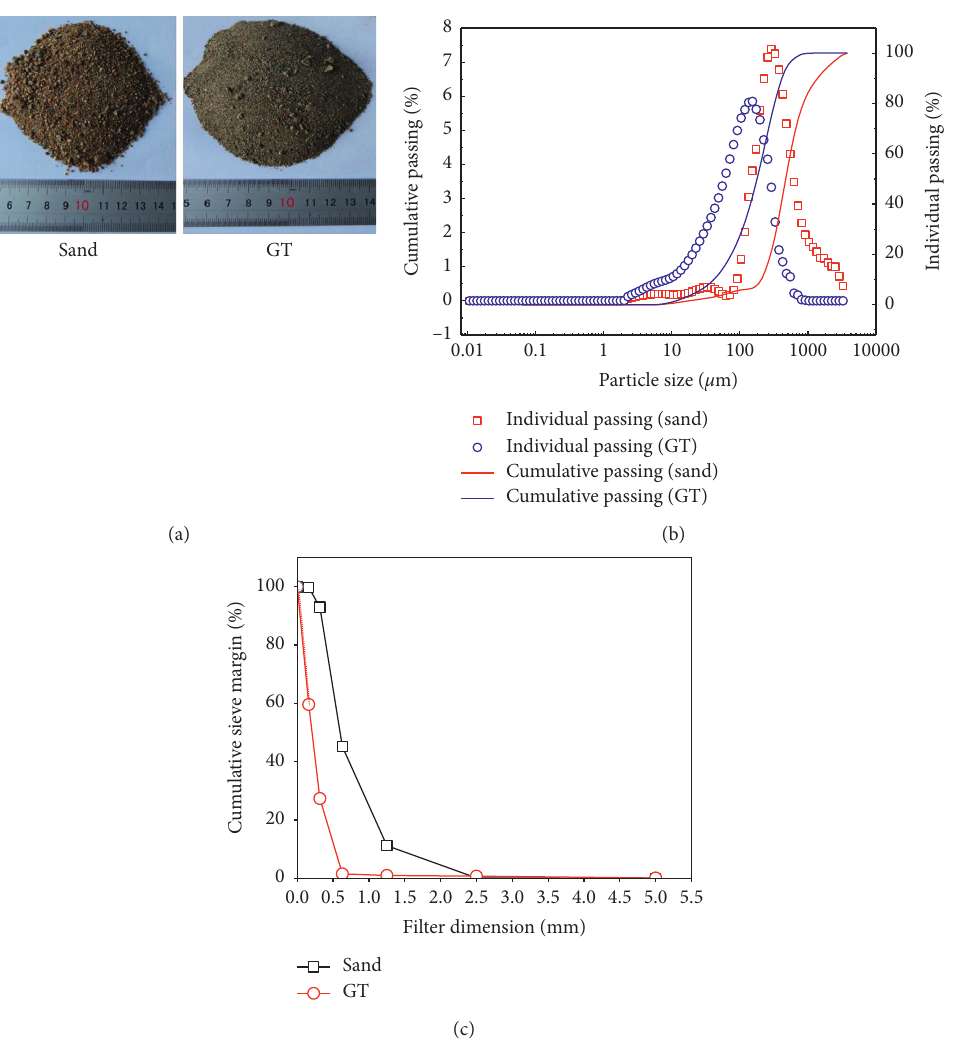
Figure 1: (a) Material appearance, (b) particle size distribution, and (c) granular gradation of GT and